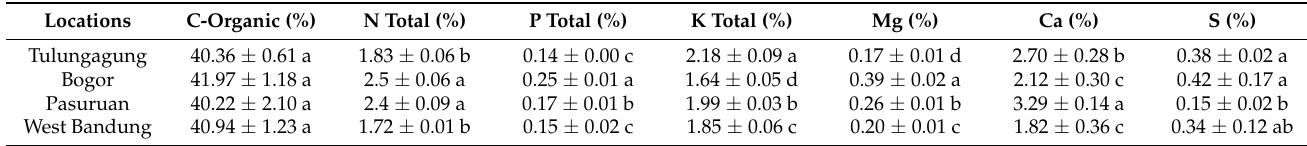
Table 6. Macronutrient status of kaffir lime leaves grown in four locations.